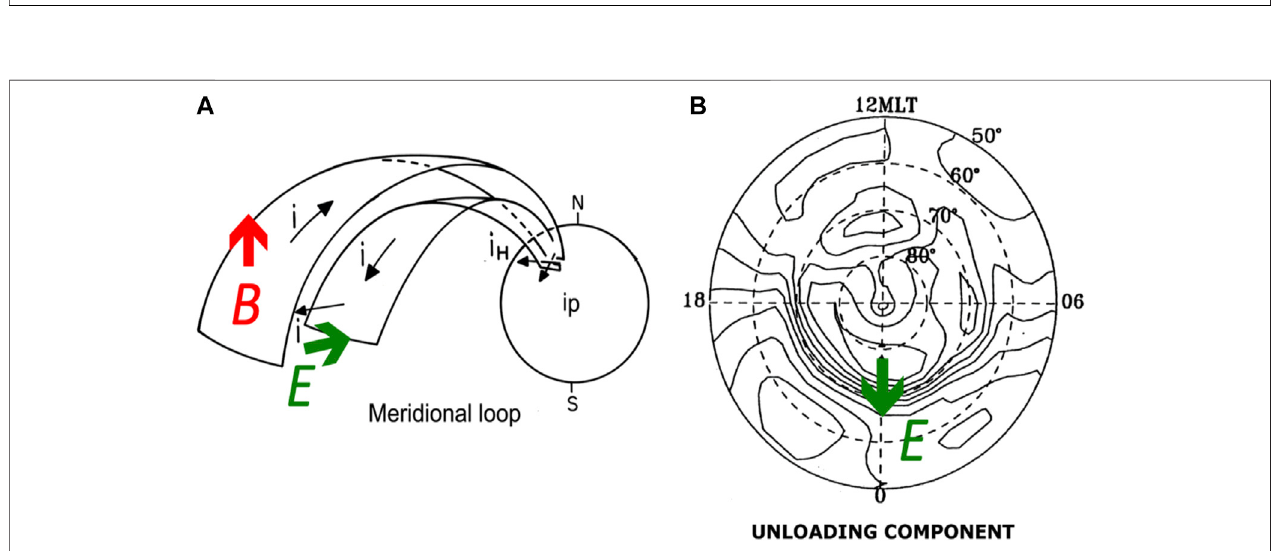
FIGURE 12 | (A) Bostrom ’ s 3-D current system for the expansion phase (Bostrom, 1964); it is driven by an earthward electric fi eld E. (B) The UL current in the ionospherededucedonthebasishethesixmeridianchainsofmagnetometers.Thecurrentisdrivenbyasouthwardelectric fi eld,whichistransferredfromEin (A) .(Sun et al., 2000).